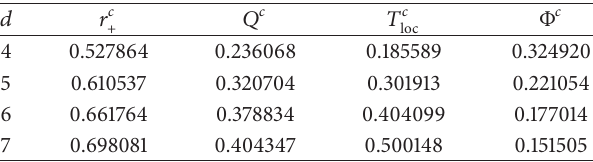
From (9) and (12), we can obtain Table 1: Numerical solutions for 𝑟 𝑐 + , 𝑄 𝑐 , 𝑇 𝑐 loc , and Φ 𝑐 for given values of 𝑑 = 4, 5,6, 7 ,